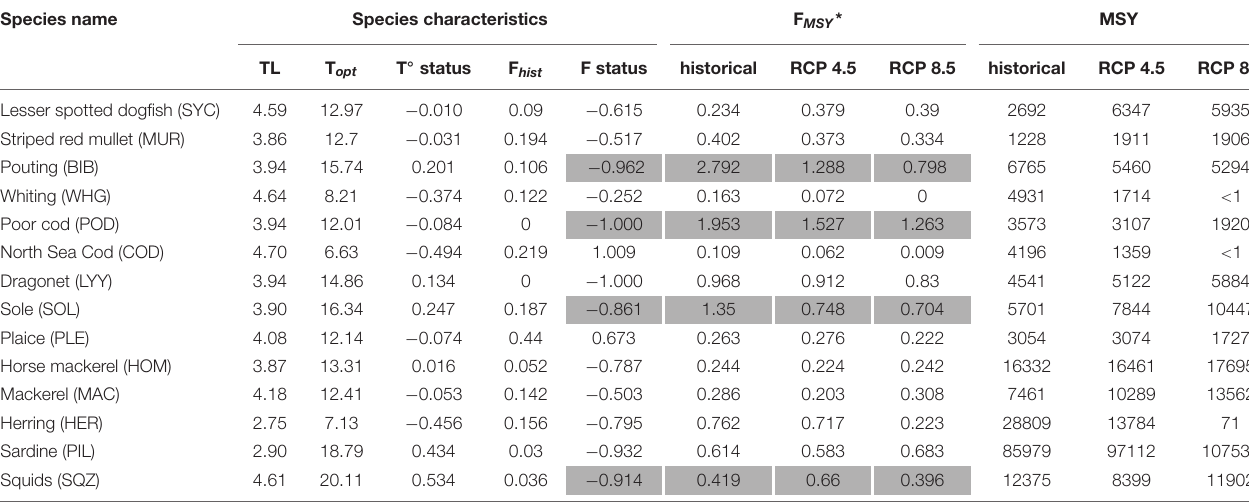
TABLE 1 | Species characteristics and reference points estimated under different